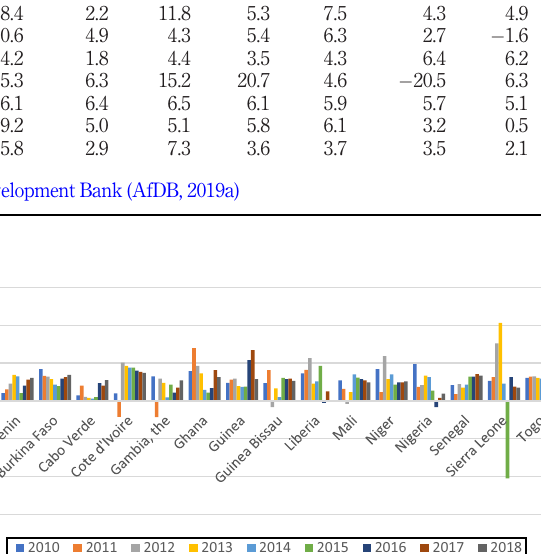
Figure 1. Real GDP growth